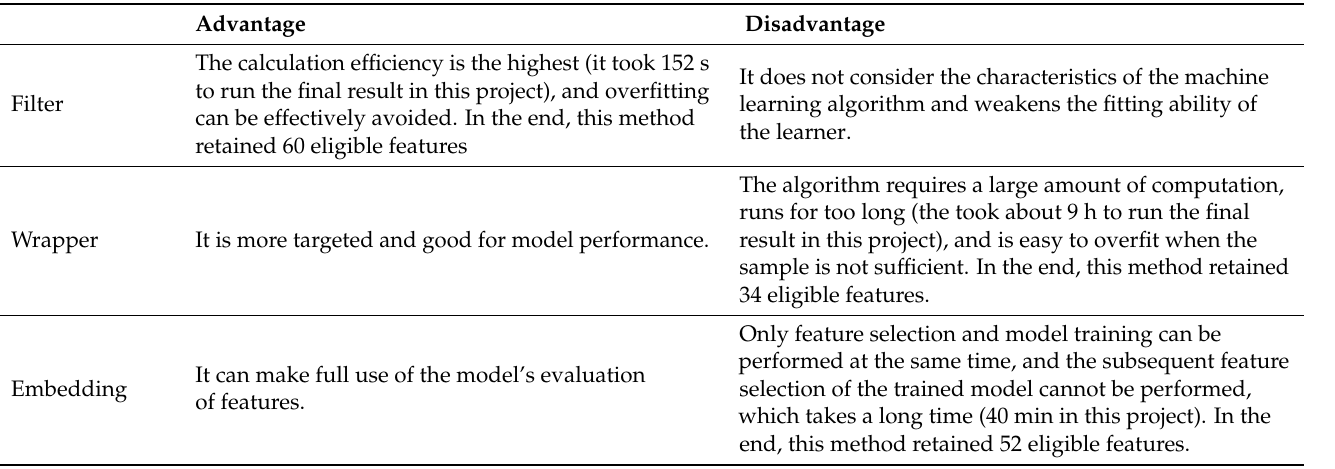
Table 3. Comparison of advantages and disadvantages of the three feature selection methods.